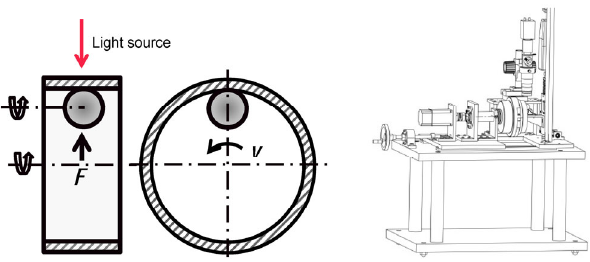
Fig. 1 Schematic of the optical measurement system based on the ball-on-ring